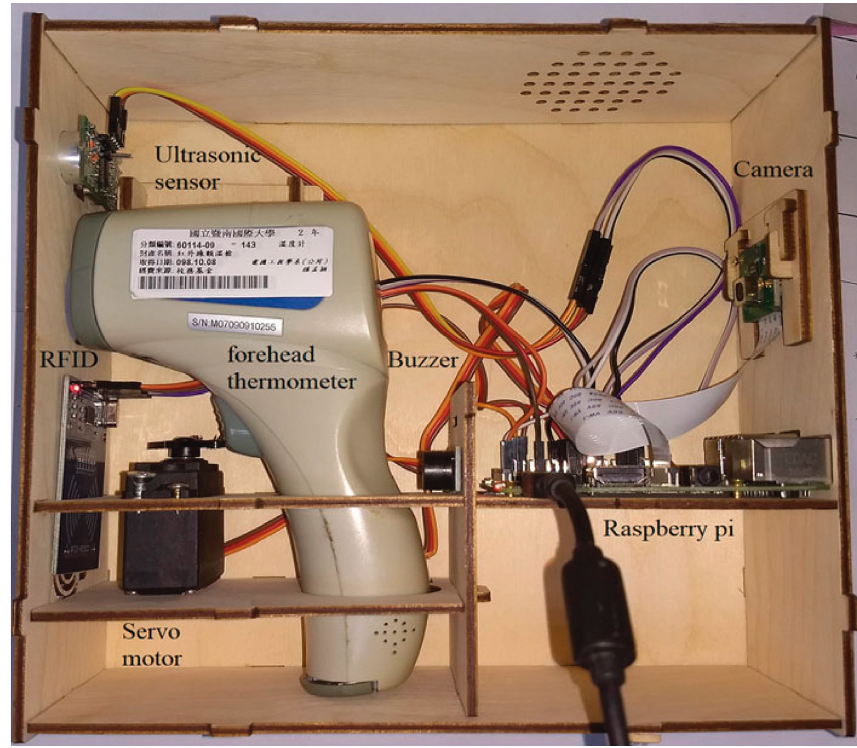
Figure 10: Autothermometer assembly.